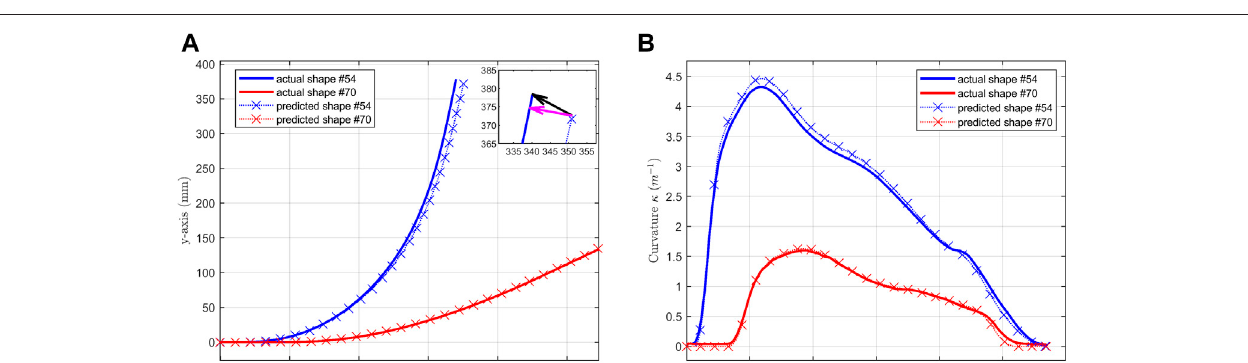
color arrow in the Figure 8A inset. There are three types of the errors: